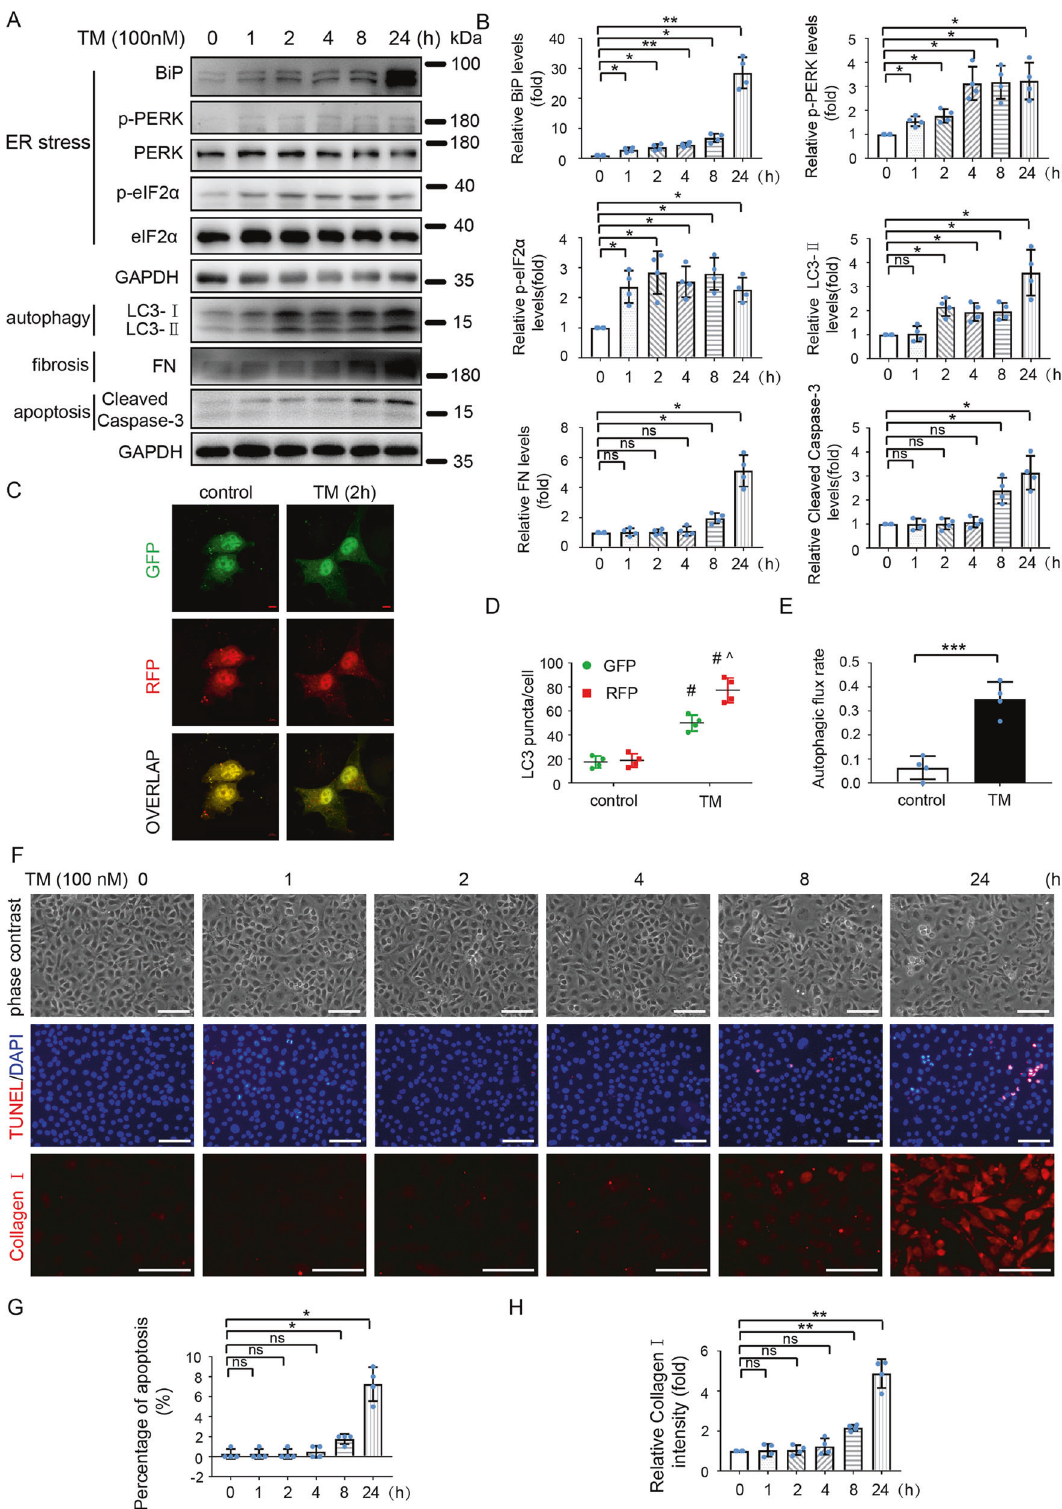
(Fig. 4A and B), and ameliorated TM-induced morphological changes (Fig. 4C). GSK2656157 also attenuated TM-induced expression of LC3-II (Fig. 4E, F), FN, and Collagen I (Fig. 4E, G, H), and dramatically reduced the number of TUNEL-positive cells and the levels of cleaved Caspase-3 in cells exposed to TM (Fig. 4C – F). In line with the fi ndings in HK-2 cells, inhibition of PERK